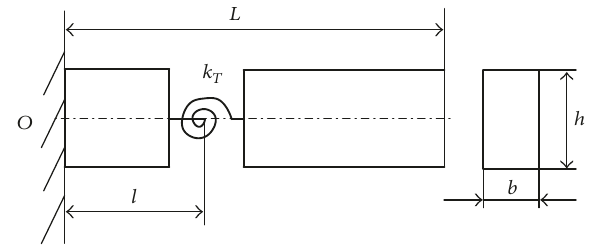
Figure 3: Stiffness model of the cracked cantilever beam.